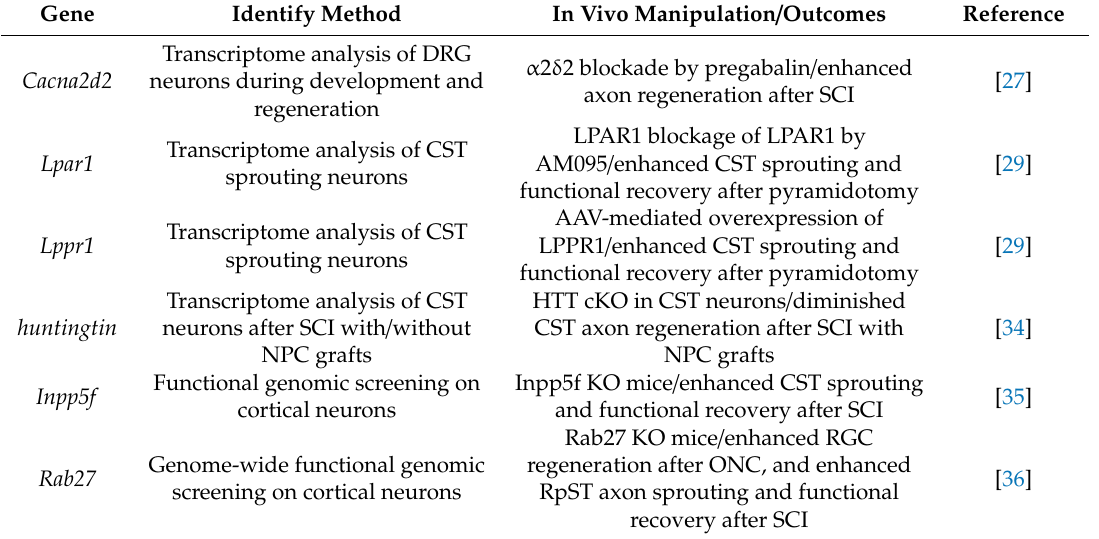
Table 1. Examples of current studies using omics to identify potential targets for axon regeneration. Gene Identify Method In Vivo Manipulation / Outcomes Reference Transcriptome analysis of Cacna2d2